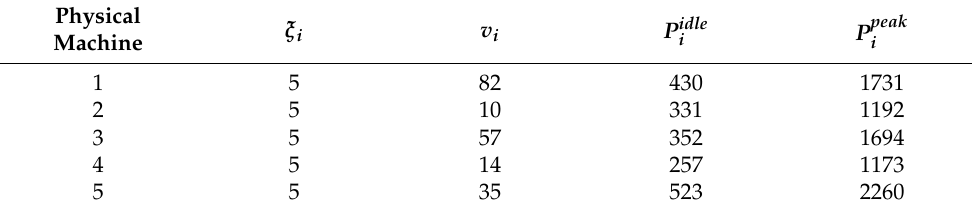
Table 2. Physical machine parameters.